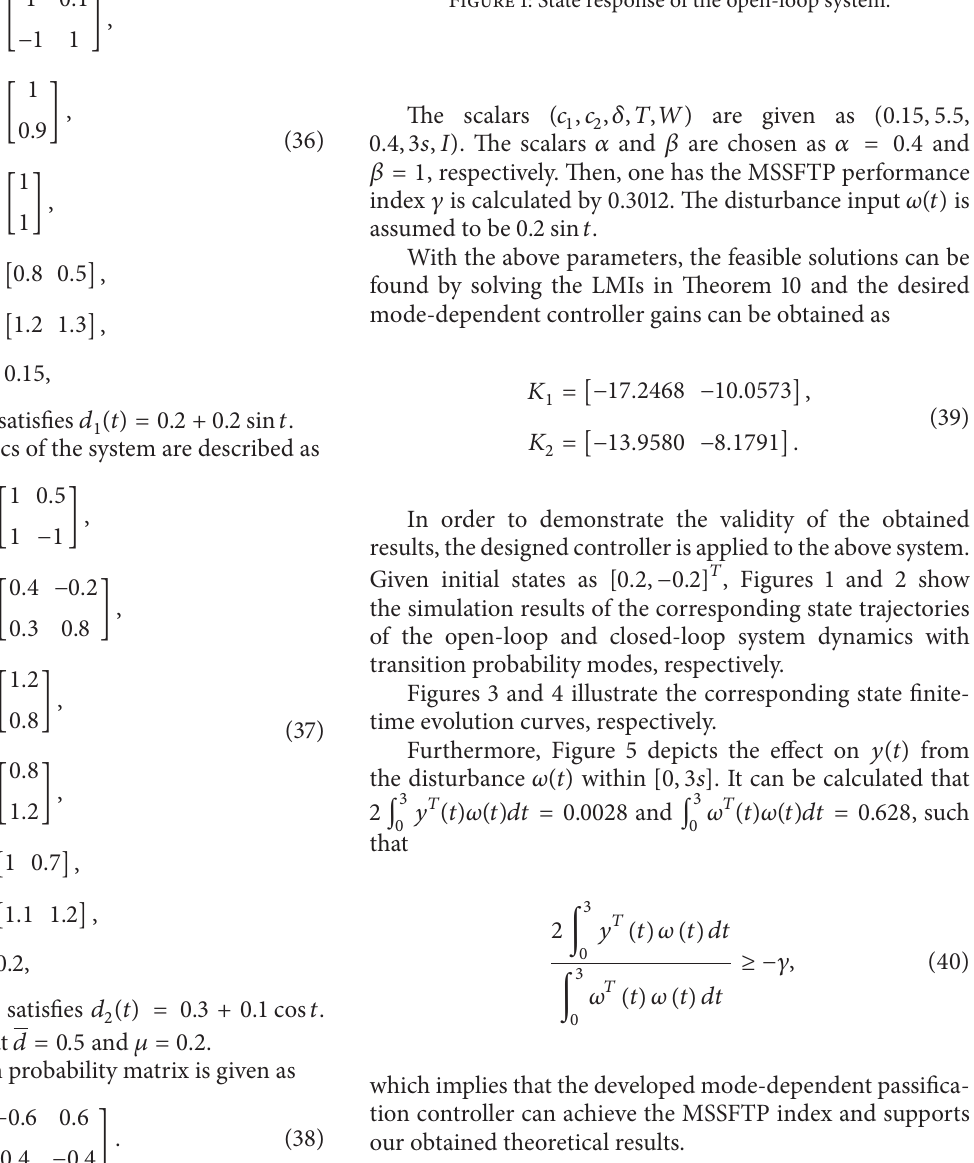
Figure 1: State response of the open-loop